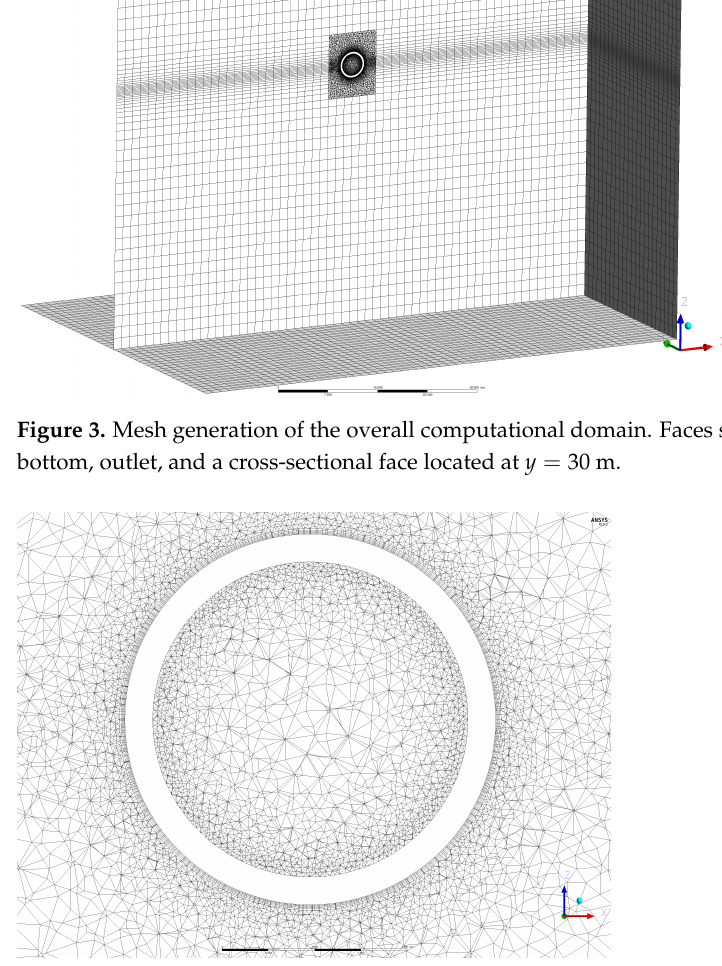
Figure 4. Mesh generation around the body surface with the mesh refinement at the interfaces and the boundary